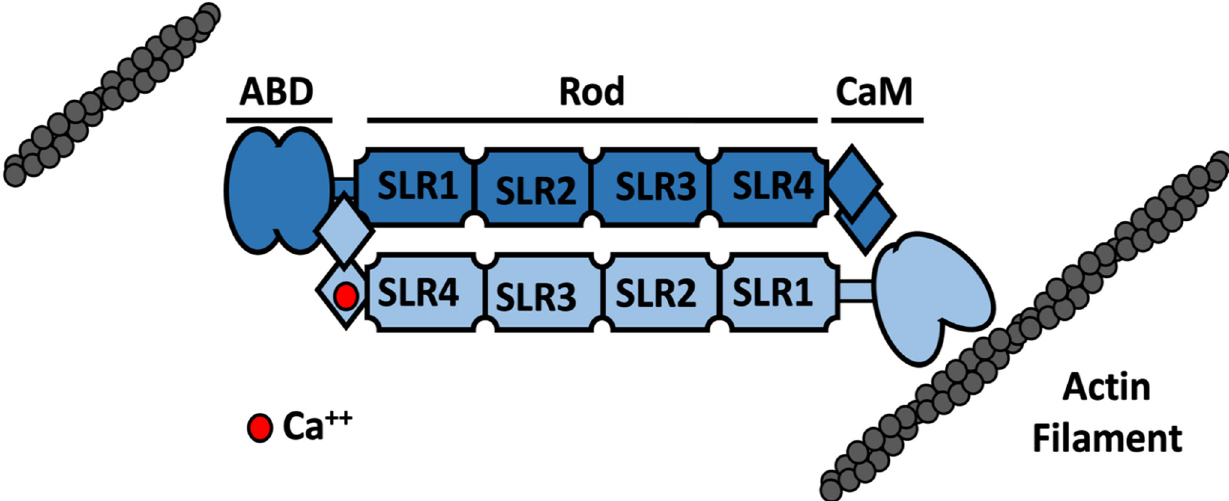
Figure 1. Schematic representation of the structure of the actinin dimer and its regulation by calcium. Actinins are ~100 kDa proteins that form dimers that are ~36 nm long and ~6 nm wide [9]. Each monomer comprises an amino-terminal actin binding domain (ABD) that is made up of two tandem calponin homology (CH1–CH2) domains. These CH domains rearrange from a closed conformation in the absence of actin to a more open, higher affinity state when bound to actin [6,12]. The rod domain facilitates the antiparallel dimerization of actinin and consists of four sprectrin-like repeats (SLRs) with a three-helix bundle structure and high sequence homology to those found in spectrin and dystrophin [6,12]. The carboxyl-terminal calmodulin-like (CaM) domain comprises four helix–loop–helix EF-hand motifs (EF1-4) [7]. EF 3–4 interacts with the neck region between the ABD and first spectrin repeat of the other actinin subunit [9,10]. In Ca ++ -sensitive actinin isoforms, EF1 can bind a single Ca ++ ion and the solution structure of the actinin-1 CaM domain suggests that while EF3-4 binds to the neck region in the presence of Ca ++ , it is not associated or only loosely associated with the neck region when Ca ++ is not bound to EF1 [11]. A conformational change involving opening of EF hand 1–2 and structural stabilisation of the domain occurs when bound to Ca ++ which also reduces the flexibility of the adjacent ABD and inhibits actin binding [11]. The Ca ++ -bound, inhibited state and Ca ++ -free, F-actin-bound states are shown here on the left and right hand sides of a single actinin dimer for illustrative purposes only.